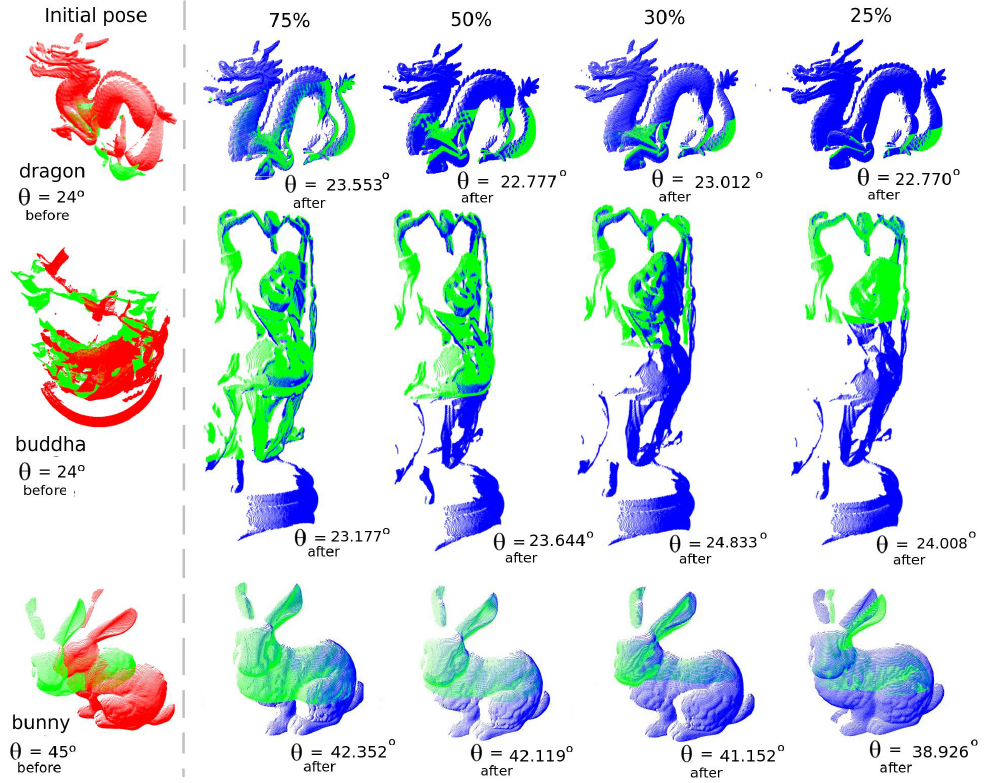
Figure 10. Partial registration of point clouds for the dragon, buddha and bunny models considering 25%, 30%, 50% and 75% overlap ratios. Note in the first column the value of θ before , referring to ground-truth. For the other columns, θ after means the result of the pose